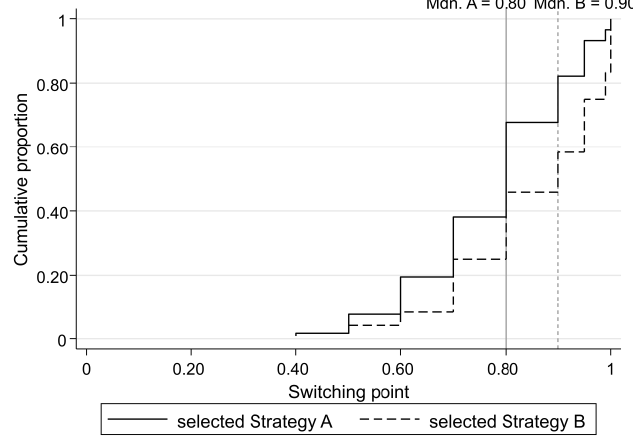
Figure 3. CDFs and the medians of switching points of participants who selected Strategy A and of those who selected Strategy B.